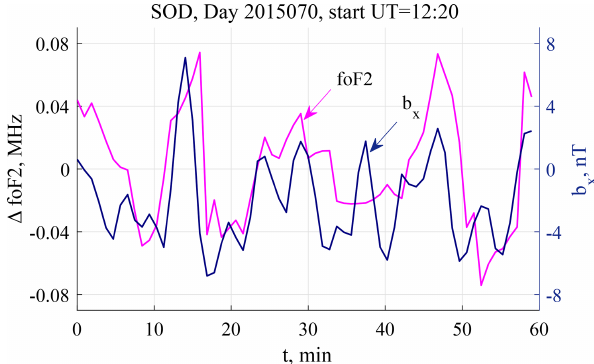
Figure 3. Variation of fo F2 and geomagnetic pulsations at SOD dur- ing event 1.